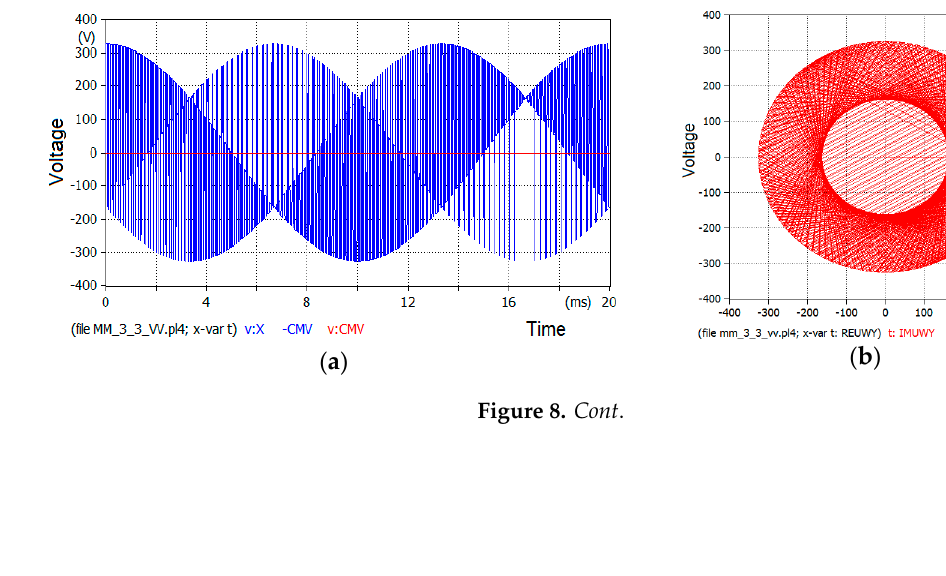
( f ) Figure 8. Output phase voltage (blue) and CMV (red) for: three-to-three-phase MC ( a ); three-to-six- phase MC ( c ); three-to-nine-phase MC ( e ). Trajectory of the output voltage for: three-to-three-phase MC ( b ); three-to-six-phase MC ( d ); three-to-nine-phase MC ( f ). The results of simulations involved in testing the possibility to control the input displacement angle are shown in Figure 9: for three-to-three-phase MC (Figure 9a,b); for three-to-six-phase MC (Figure 9c,d); and for the three-to-nine-phase MC (Figure 9e,f). In the parts (a), (c) and (e) of Figure 9, the input phase voltages and input MC currents are shown. The parts (b), (d) and (f) of Figure 9 depict the input displacement angle versus referenced input displacement angle. The values of the displacement angle are determined between input voltage and fundamental component of the current. As could be noticed in each of the three figures, implementation of the Venturini modulation functions into modulation method causes the dependence of the input displacement angle on the referenced value of this angle to have a shape approximately corresponding to the function tangent, which is consistent with the analytical description of the modulation method. A positive value of the input displacement angle means that the fundamental harmonic of input current is lagging. For a negative value of this angle, the fundamental harmonic of input current has leading nature.